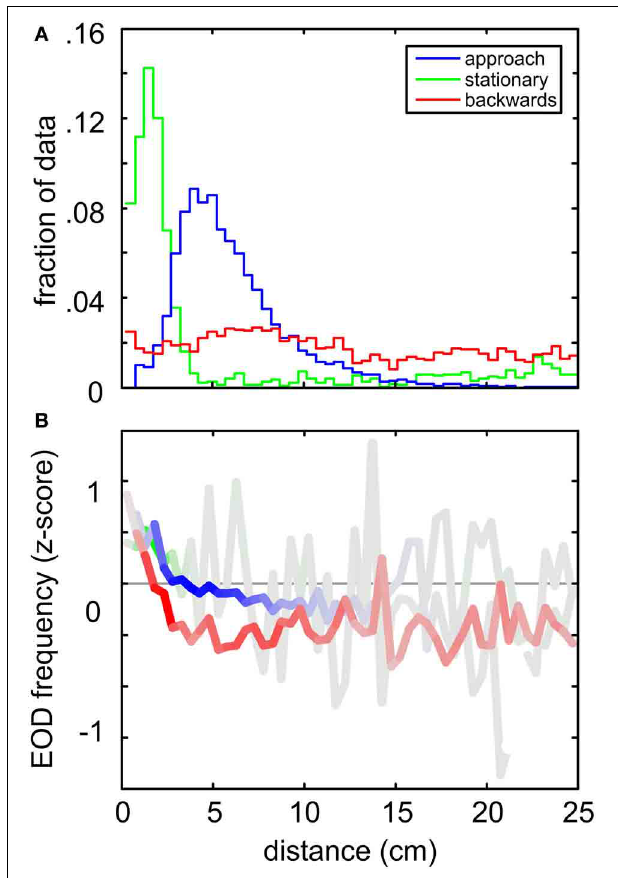
FIGURE 6 | Comparison between the spatial distributions and the EOD frequencies for the three behaviors analyzed in detail. (A) Relative spatial distribution of “object approach” (blue), “stationary behavior” (green) “backwards swimming” (red) behaviors. Data was binned (bin width 1cm) with respect to the Euclidian distance where the behavioral patterns were found. The frequency of occurrence is expressed relative to the size of the complete dataset ( n = 277585 frames) at each distance. Stationary and object approach behaviors both peaked close to the object, while backwards swimming behavior was roughly equally distributed. Note that the classification of backwards and stationary behavioral patterns was based on kinematic data exclusively. (B) Averaged z-scored EOD frequencies occurring during the three behaviors as a function of distance to the cube. The color intensity indicates the relative amount of data contributing to the individual means. Note that for all behaviors an increase in fEOD toward the object is